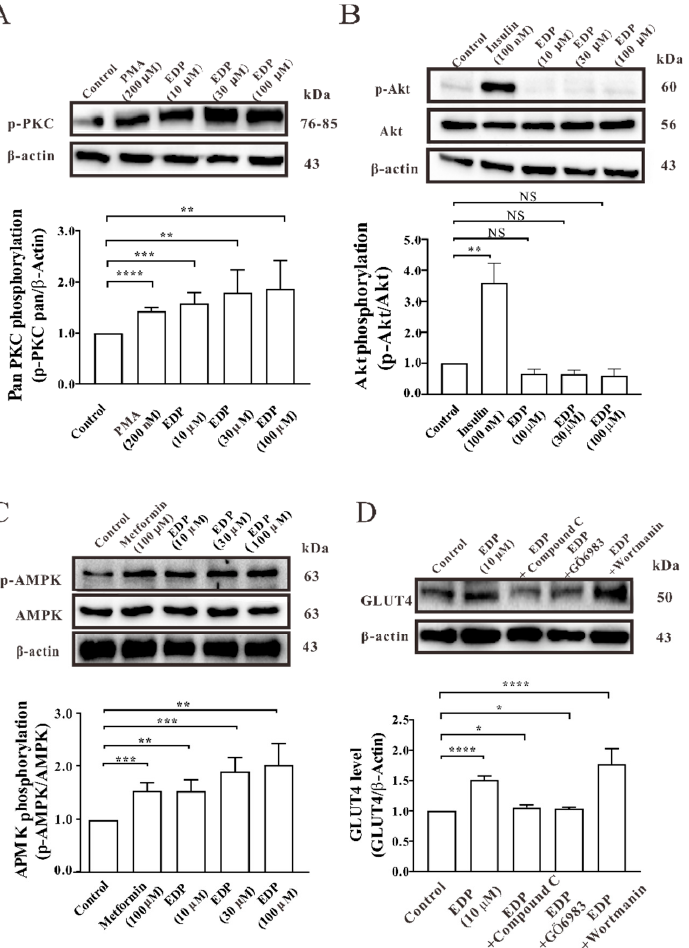
Figure 4. Estradiol Dipropionate (EDP) induces GLUT4 expression in L6 cells by promoting phos- phorylation of the PKC and AMPK signaling pathways. ( A ) PMA and different concentrations of EDP significantly increased PKC phosphorylation levels after 30 min of stimulation. ( B ) The phosphorylation of Akt had no effect on L6 cells stimulated by EDP at different concentrations for 30 min. ( C ) The phosphorylation of AMPK increased significantly after 30 min of stimulation with 100 µ M metformin and different concentrations of EDP. ( D ) The effect of 10 µ M EDP-induced GLUT4 protein expression was blocked by two inhibitors, PKC inhibitor compound C and AMPK inhibitor Gö6983 for 30 min in L6 cells. NS p > 0.05; * p < 0.05; ** p < 0.01; *** p < 0.001; **** p <